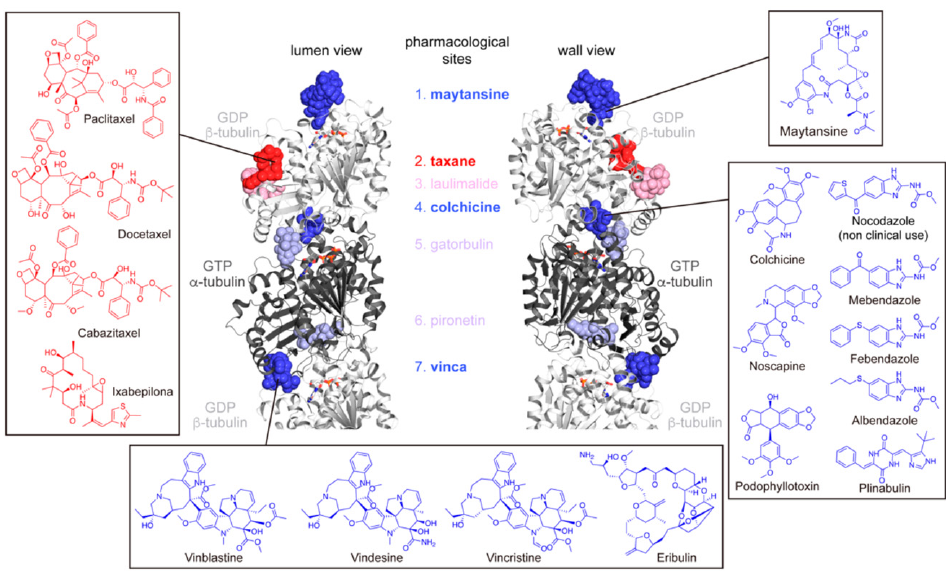
Figure 1. Tubulin pharmacological binding sites. MT lumen (left) and wall (right) views of α , β - tubulin heterodimer ( α -tubulin GTP-bound in grey, β -tubulin GDP-bound in white) in ribbon rep- resentation. The seven known pharmacological binding sites are color-coded: blue for MDAs, red for MSAs, dark colors for sites targeted by clinically used drugs and, light colors for sites targeted by compounds not of clinical use. In the same color code are the structure and name of the MTAs assayed in this study, which are grouped by targeted binding